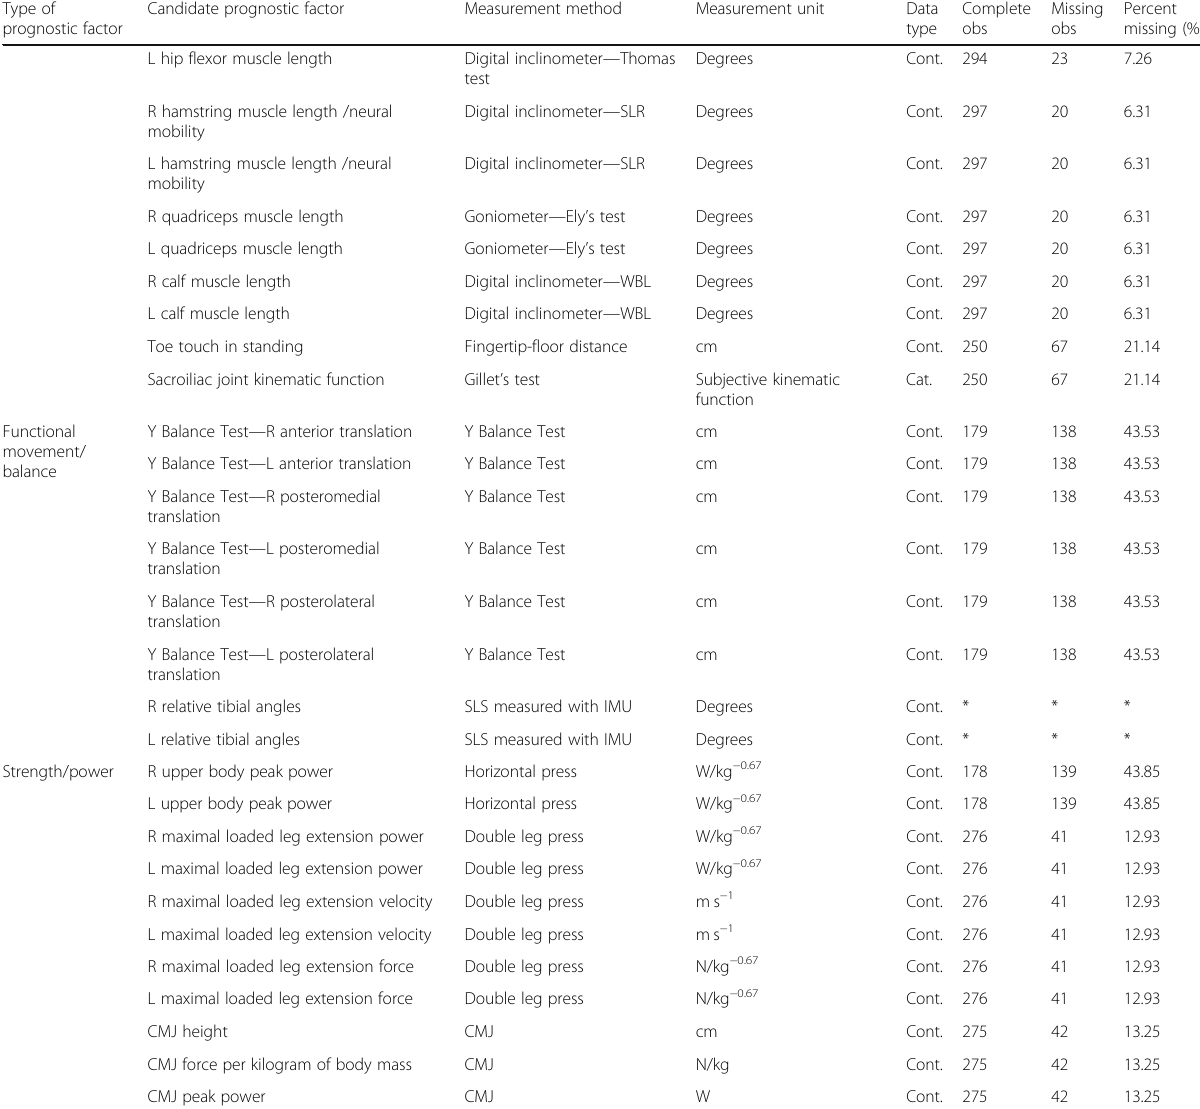
Table 1 List of candidate prognostic factors, methods and units of measurement, frequency of complete and incomplete observations and proportion of missing observations